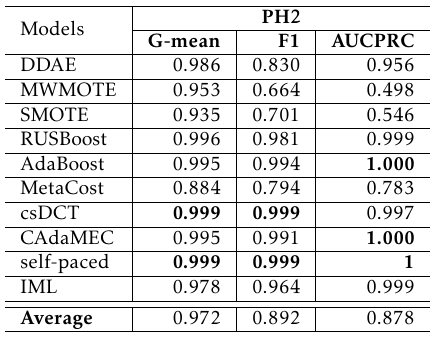
Table 10. Overall Results for PH2